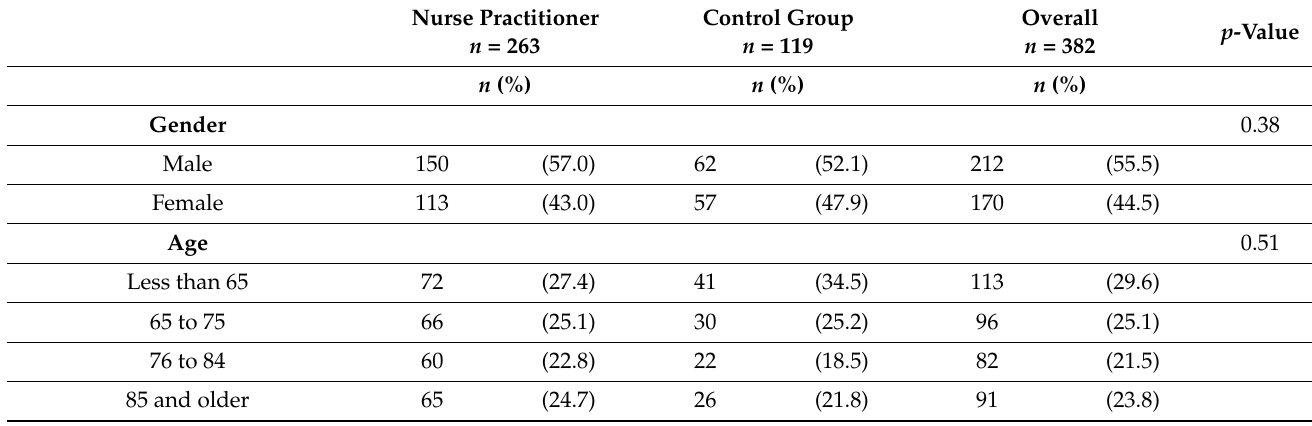
Table 1. Baseline